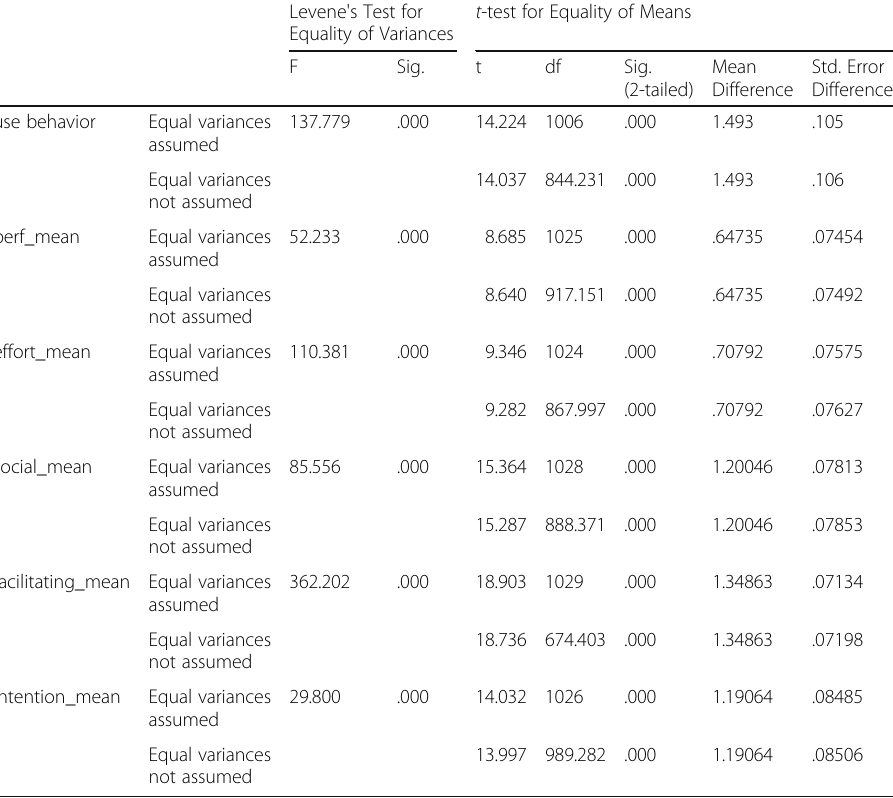
Table 7 Independent Samples Test